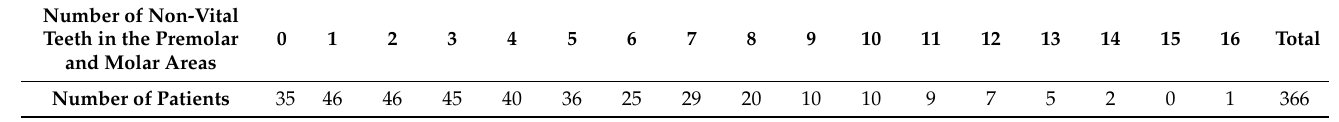
Table 3. Number of patients by number of non-vital teeth in the premolar and molar regions.